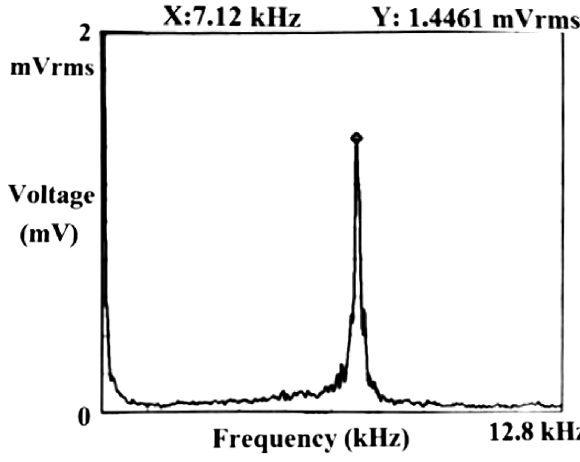
8. Plasma instability at rf power ¼ 250 W, radio frequency ¼ 18 GHz, and injection pressure ¼ 1 . 3 × 10 − 6